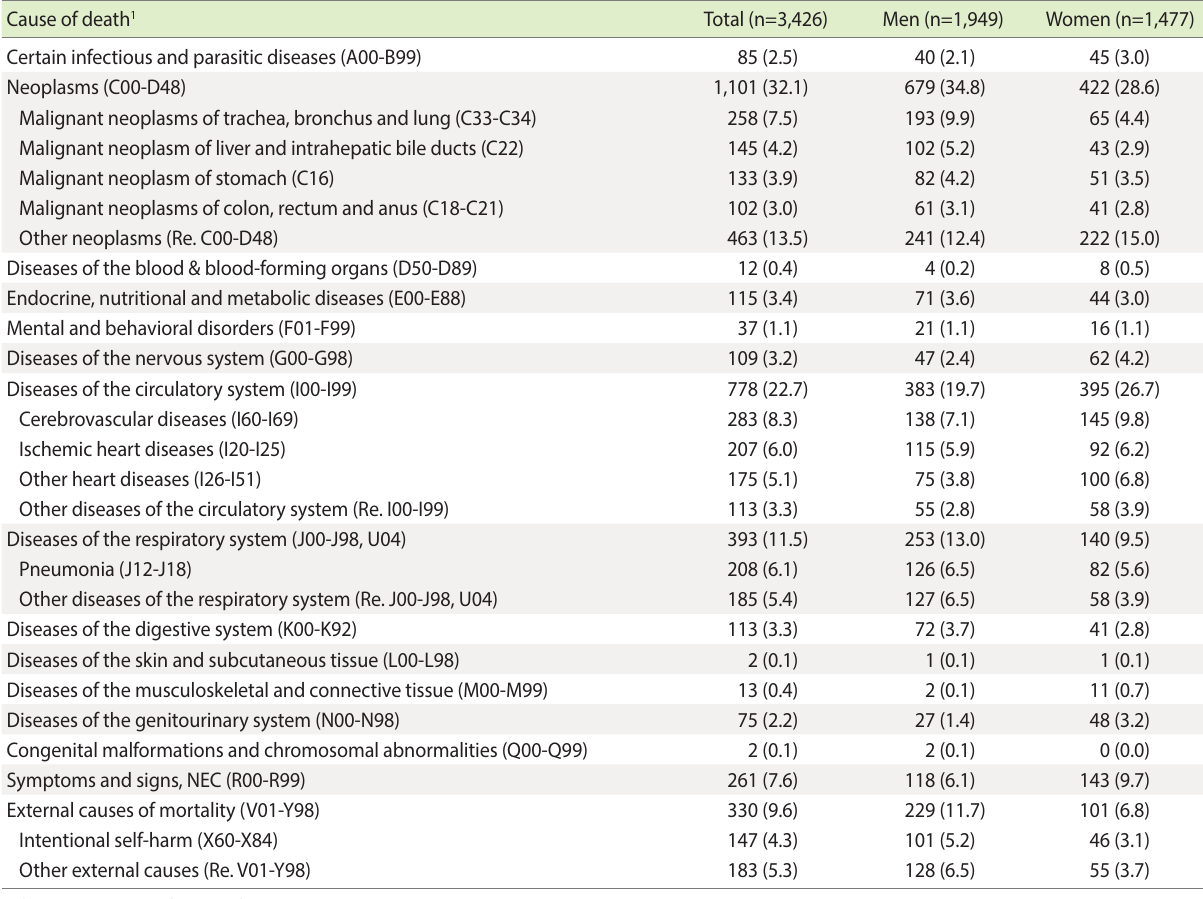
Table 4. The distribution of cause of death among adults aged 19 years in the Korea National Health and Nutrition Examination Survey linked to Cause of Death data (dataset version 1.2.)